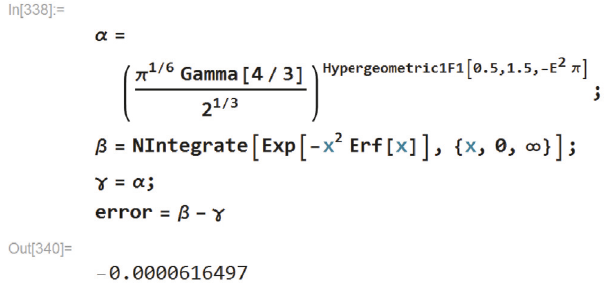
Figure 6: Error approximation for T( +∞